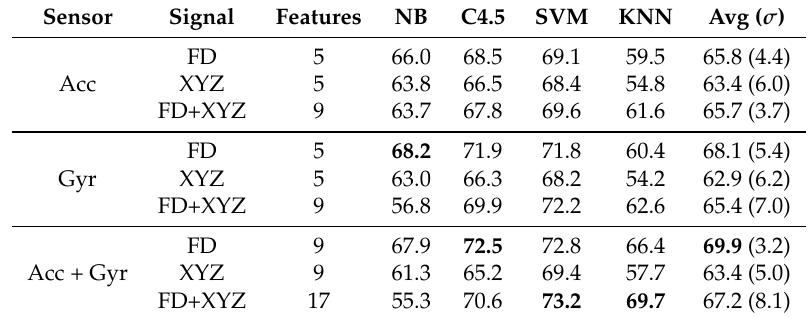
Table 1. Correctly classified instances (%) using unbalanced data, number of instances = 15,691. Sensor Signal Features NB